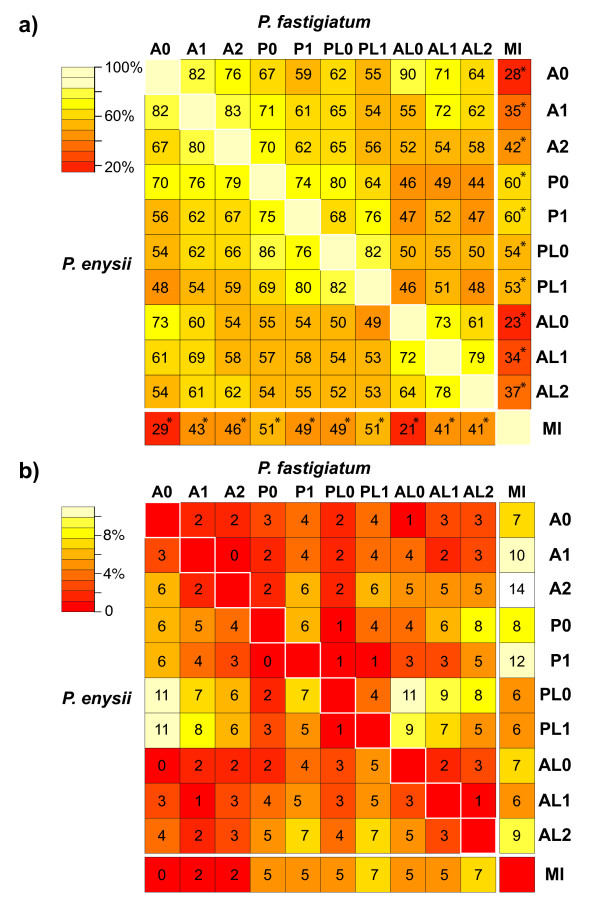
a) Number of genes investigated with different sets of reference genes. Bar heights indicate the number of genes which were surveyed with tag profiling (TP, light shading) and a previous microarray study (MI, dark shading). With the small reference sets, increasing the number of mismatches in mapping Pachycladon tags to Arabidopsis TAIR10 protein coding sequences increased the number of investigated genes, but did not reach the number of genes investigated when mapping Pachycladon tags to P. fastigiatum full-length ESTs. Clearly, more genes were investigated when tags were mapped against all contigs of the P. fastigiatum EST library or the entire TAIR10 collection. For abbreviations of different sets of reference genes see Additional file 3. b) Number of differentially expressed genes (DEGs) in P. enysii and P. fastigiatum with different sets of reference genes. The number of DEGs identified in each species is correlated with the total number of genes amenable to study for differential gene expression (compare Figure 2a and Figure 2b). The percentages of up-regulated genes in relation to the investigated gene sets ranged from 6-18% in P. fastigiatum and from 9-22% in P. enysii. Except for reference sets PL0 and AL2, more DEGs were identified in P. enysii than in P. fastigiatum.